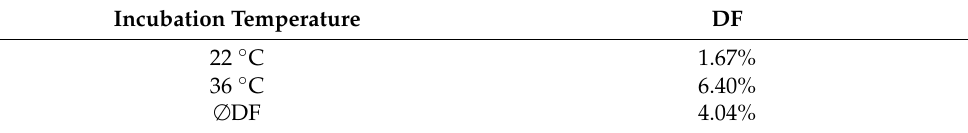
Table 8. Decontamination factor.